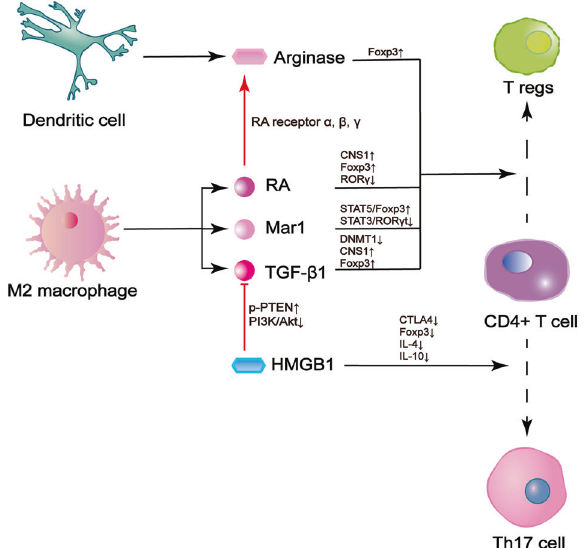
Fig. 4 Regulation of T cell differentiation by M2 macrophages. M2 macrophages produce various factors and modulate the transcrip- tion of genes, including Foxp3, whose expression is increased, and ROR γ t, whose expression is decreased. These alterations ultimately lead to Treg differentiation. One important factor, retinoic acid (RA), also activates arginase in dendritic cells and achieves synergism. Other inhibitory factors include HMGB1, which prevents Treg polarization by interfering with induction by M2 macrophage or directly decreases the levels of Treg-related transcription factors. HMGB1 high-mobility group box-1 protein, Akt/PKB protein kinase B, Mar1 maresin 1, DNMT DNA methyltransferase, CTLA4 cytotoxic T- lymphocyte-associated protein 4, CNS1 conserved noncoding sequence-1, RA retinoic acid, TGF tissue growth factor, p-PTEN phosphorylated phosphatase and tensin homolog deleted on chromosome 10, PI3K phosphatidylinositol